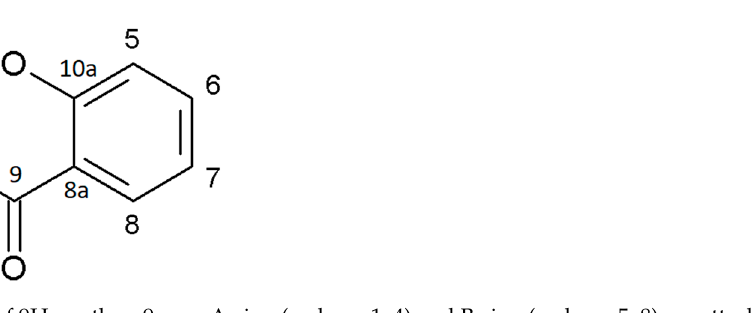
Figure 1. Structure of 9H-xanthen-9-one. A-ring (carbons 1–4) and B-ring (carbons 5–8) are attached through an oxygen atom and a carbonyl group.